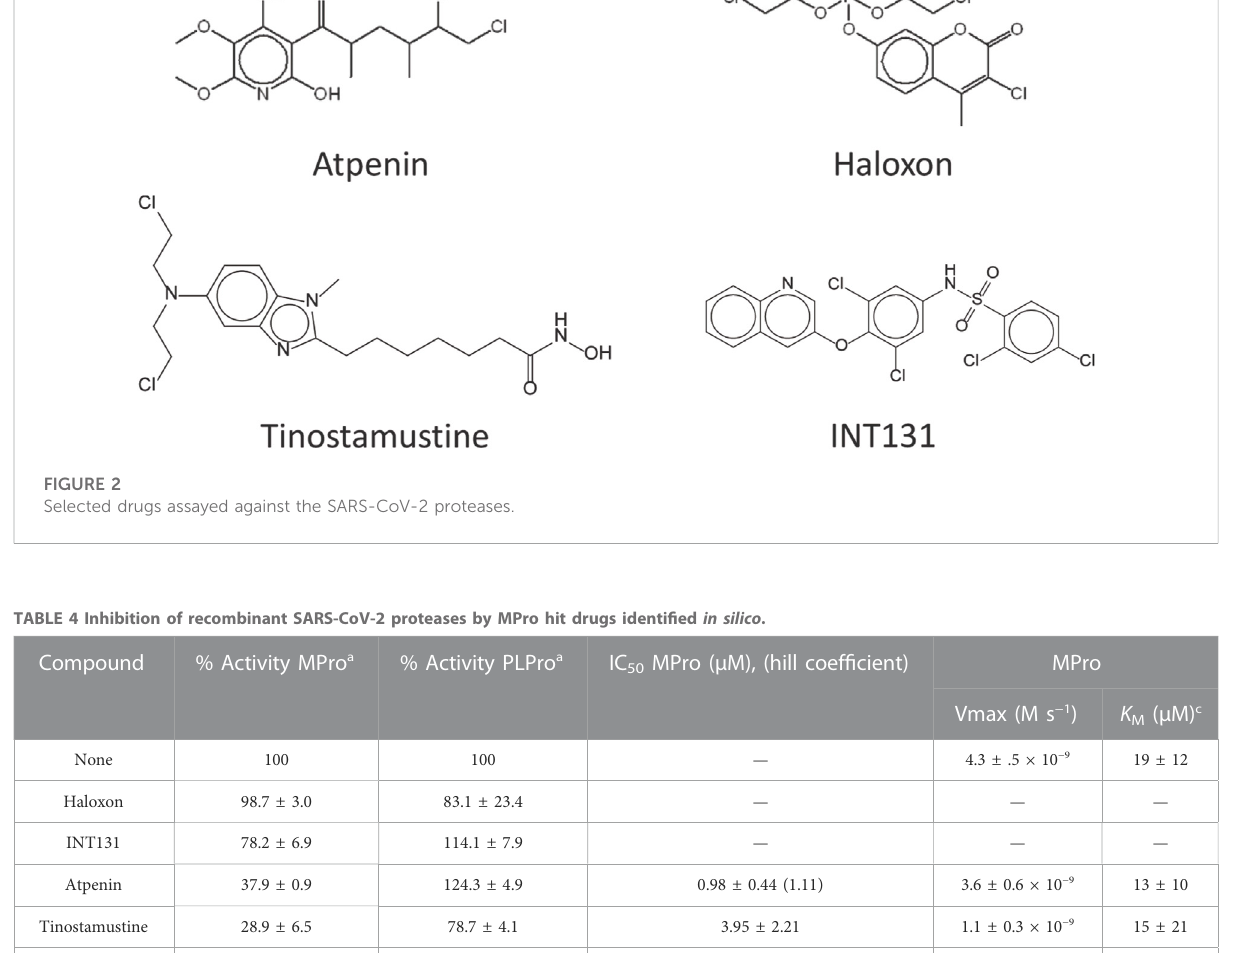
same order of magnitude for atpenin (IC 50 = 1 μ M) and tinostamustine (IC 50 = 4 μ M), and > 20-fold lower for ebselen (IC 50 = 50 nM; Table 4 and Figure 3A).